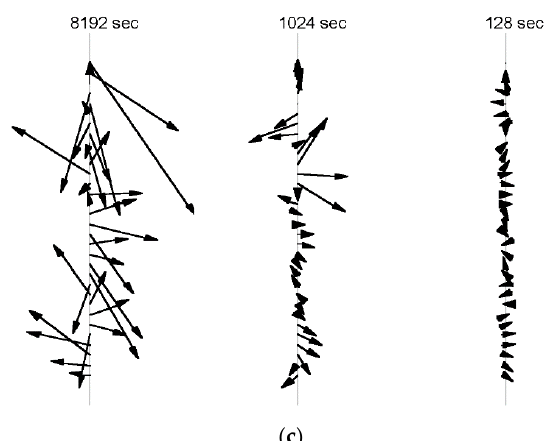
Figure 2. ( a ) Observations of temperature at 1 Hz frequency from the ER-2 aircraft flying at 200 ms − 1 at approximately 20 km altitude for 10 h 15 m on 19890220 (yyyymmdd), into a headwind of the polar night jet stream, which was aligned between (59 ◦ N, 6 ◦ E) and (38 ◦ N, 75 ◦ W). The fluctuations are atmospheric variability, and the instrumental noise is insignificant. ( b ) The horizontal wind speed corresponding to the temperature measurements in ( a ). Again, instrumental noise is not evident. ( c ) The horizontal wind shear vectors derived from the observations in ( b ), averaged over three intervals differing by a factor of eight. The directions vary over 360 ◦ and unidirectional flow at uniform velocity is nowhere evident. That behaviour is typical of the 140 ER-2 flight segments obtained during polar ozone missions from 1987 to 2000.